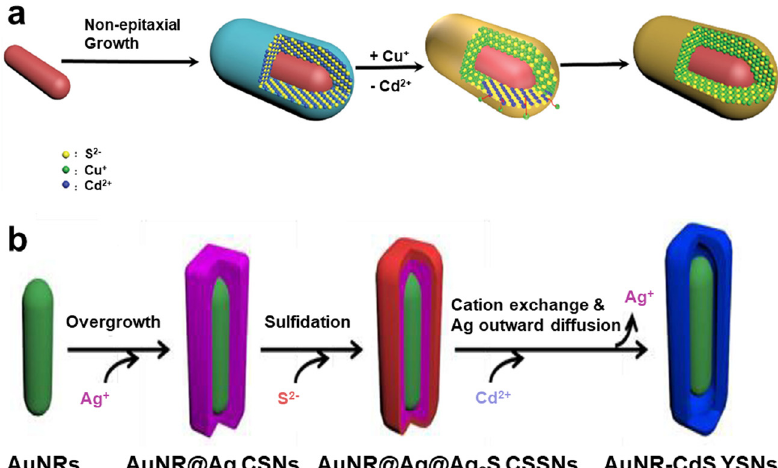
Figure 2: ( a ) Synthesis scheme of Au@Cu 2 − x S CS NCs by cation exchange between Au@CdS nanocubes and Cu + [ 36 ] , reproduced with permission. Copyright 2020, American Chemical Society. ( b ) Schematic of the synthesis route of AuNR - CdS YSNs [ 82 ] , reproduced with permission. Copyright 2018, Royal Society of